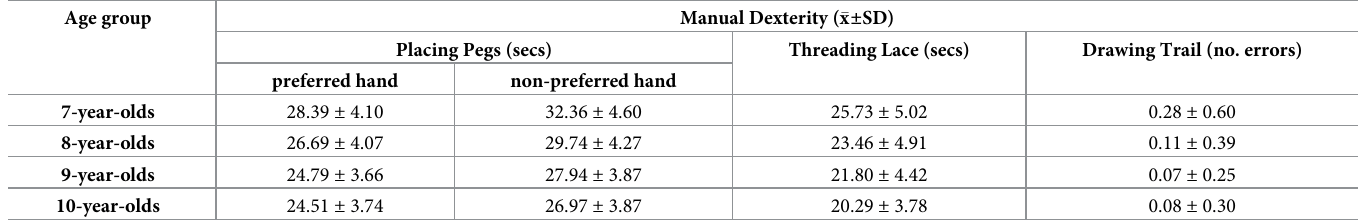
Table 2. Movement performance in the Manual Dexterity test of each age group (n = 335). Age group Manual Dexterity ( � x± SD) Placing Pegs (secs) Threading Lace (secs) Drawing Trail (no. errors) preferred hand non-preferred